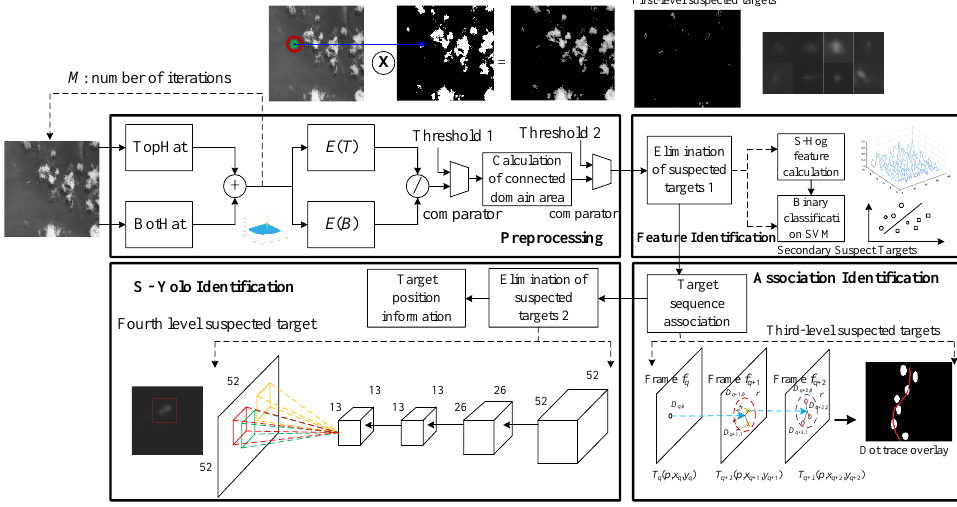
Figure 1. The basic framework of ship target detection algorithm in low-resolution broad area se- quence remote sensing images. sequence remote sensing